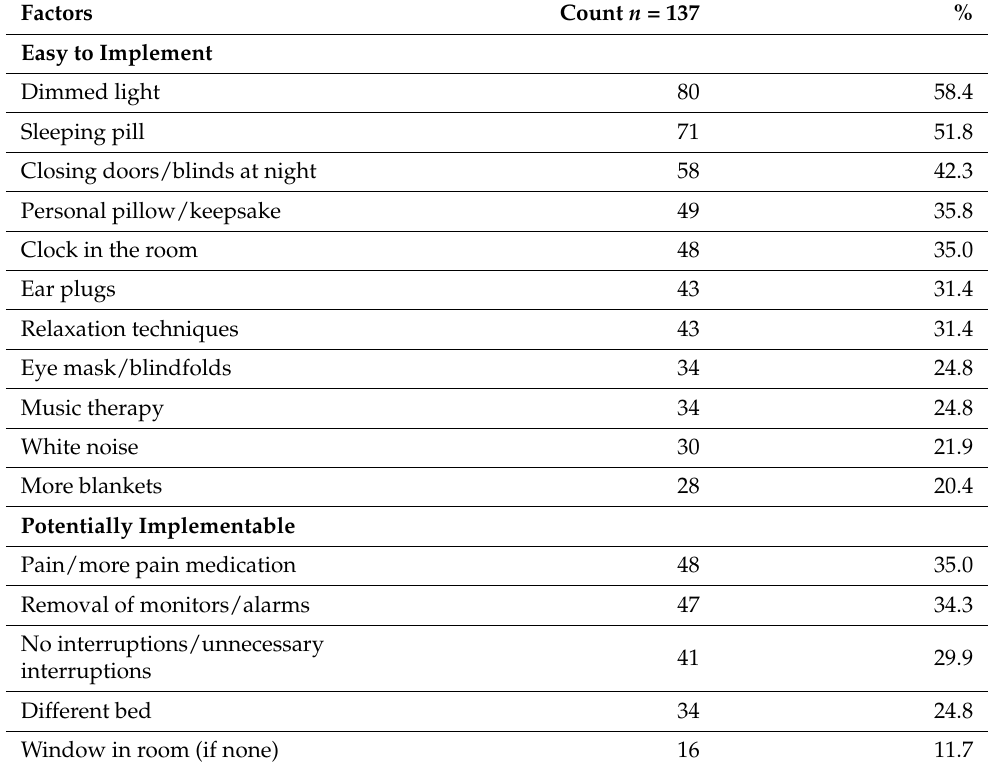
Table 2. Factors patients felt would improve their sleep in the